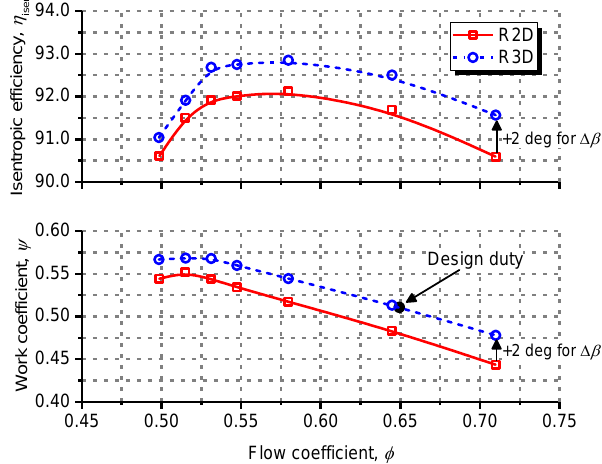
Figure 21. Characteristics of the R2D and R3D with tip clearance for 100% speed.